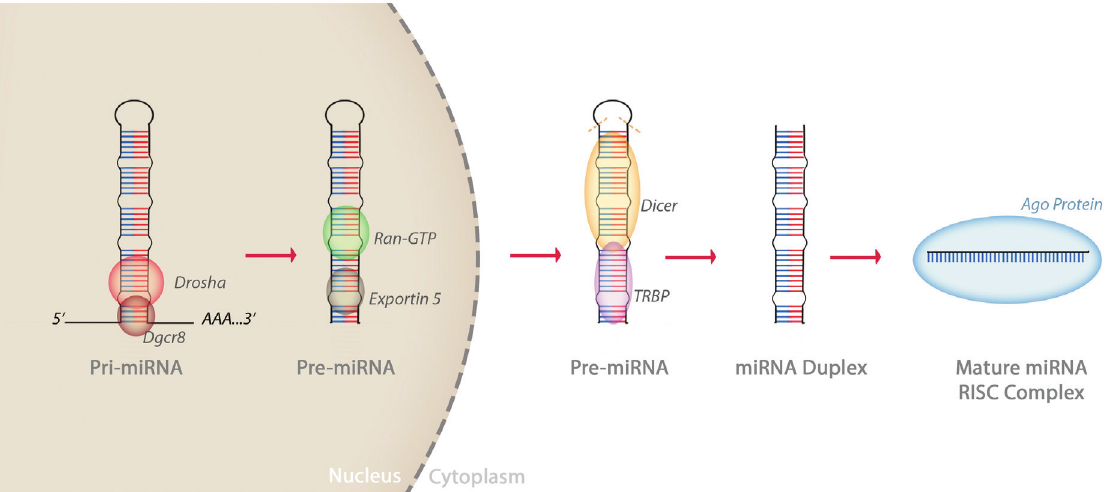
Figure 1 Canonical pathway of miRNA